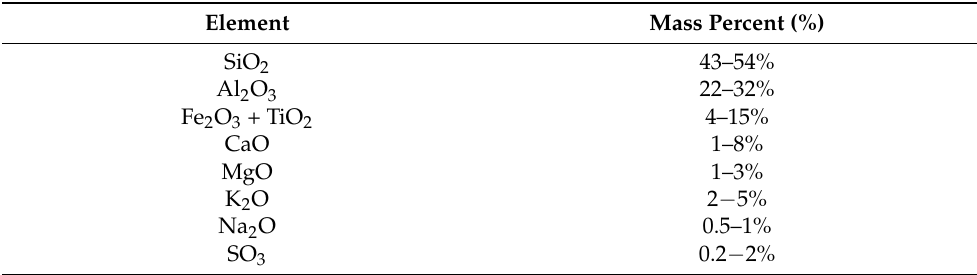
Table 1. Chemical composition of Coal fly ash